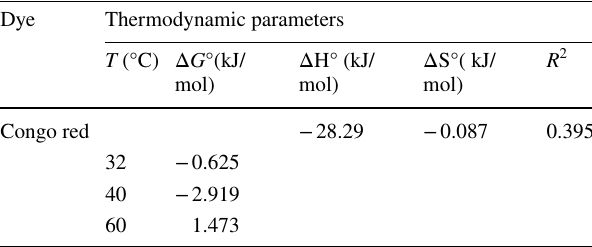
Table 3 Thermodynamic parameters for the adsorption of CR onto banana